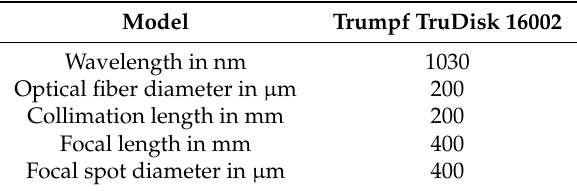
Table 2. Laser beam welding system specifications.